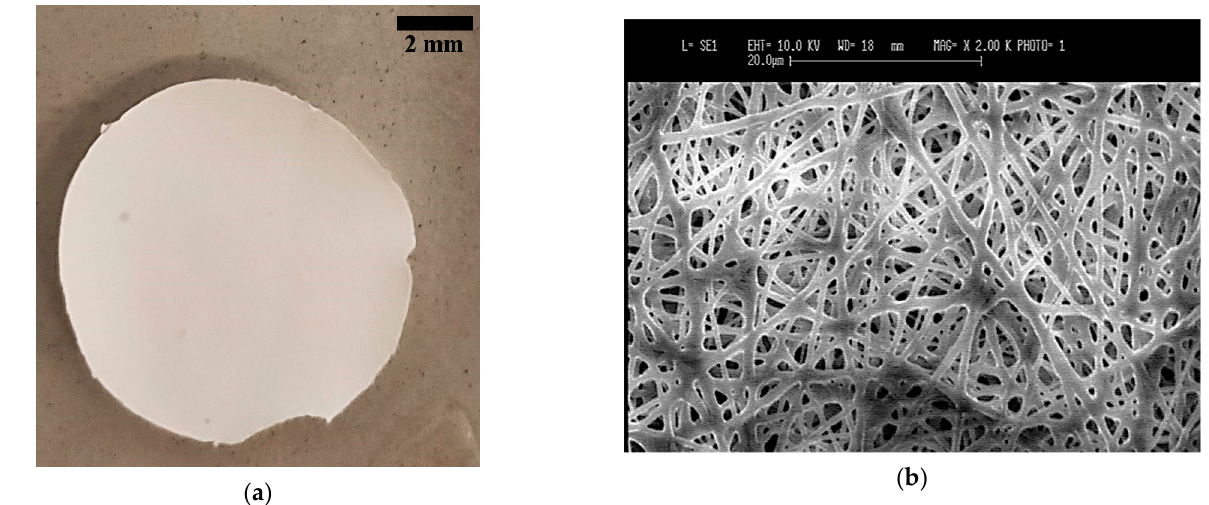
Figure 5. ( a ) Appearance of electrospun BMSF/PCL scaffolds after fabrication before the immersion in ethanol or PBS. Scale bar = 2 mm; ( b ) SEM micrographs of electrospun BMSF/PCL scaffolds (top view). Scale bar = 20 µm.